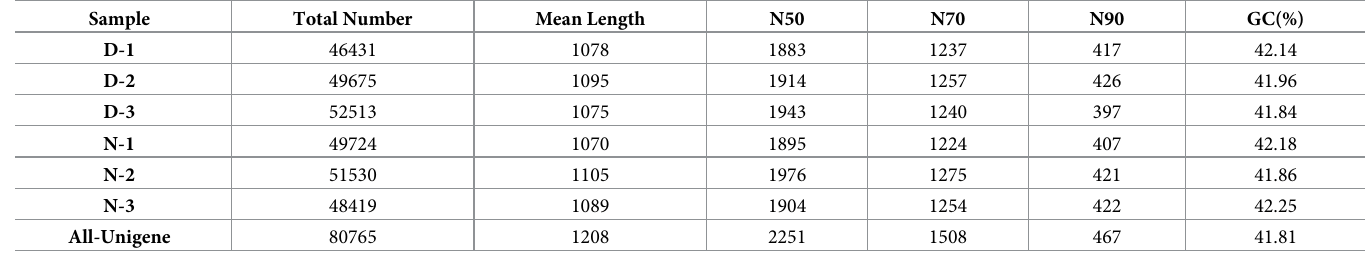
Table 2. Quality metrics of unigenes. N50: a weighted median statistic in which 50% of the total length is contained in unigenes greater than or equal to this value. GC (%): the percentage of G and C bases in all unigenes.